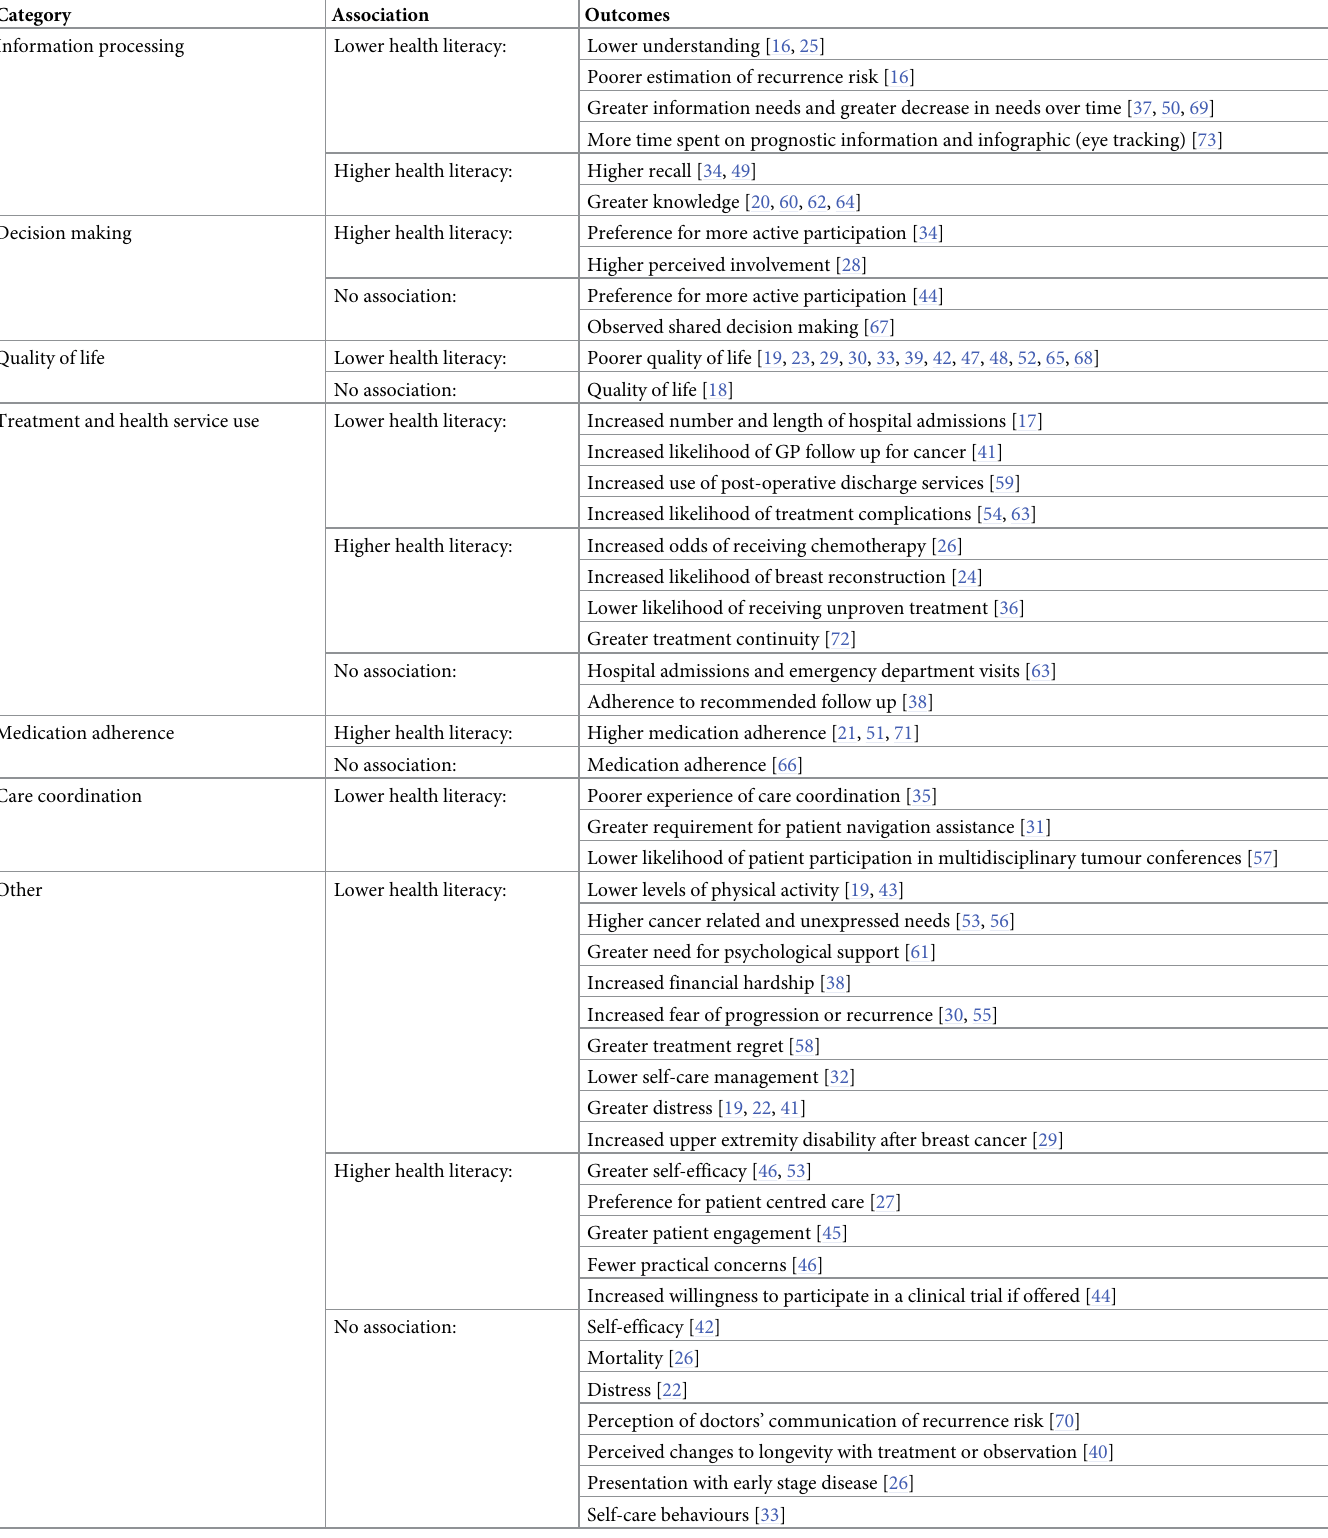
Table 2. Association of outcomes to health literacy reported by included